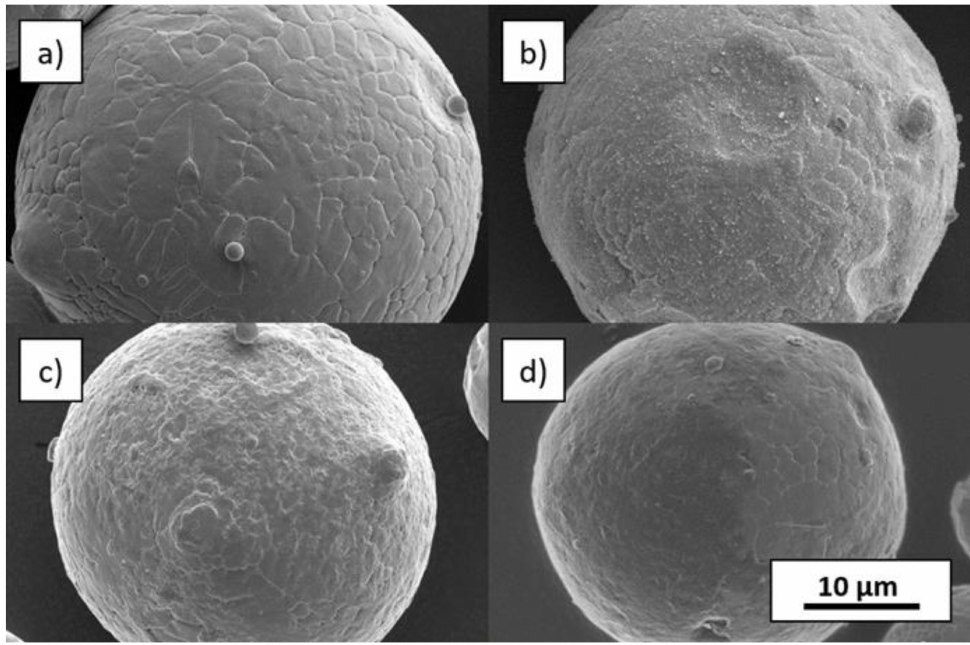
Figure 5. SEM pictures at 10,000 × magnification: ( a ) feedstock 1.2709, ( b ) 1 vol.% SiC, ( c ) 1 vol.% IOB and ( d ) 0.75 vol.% FLG.